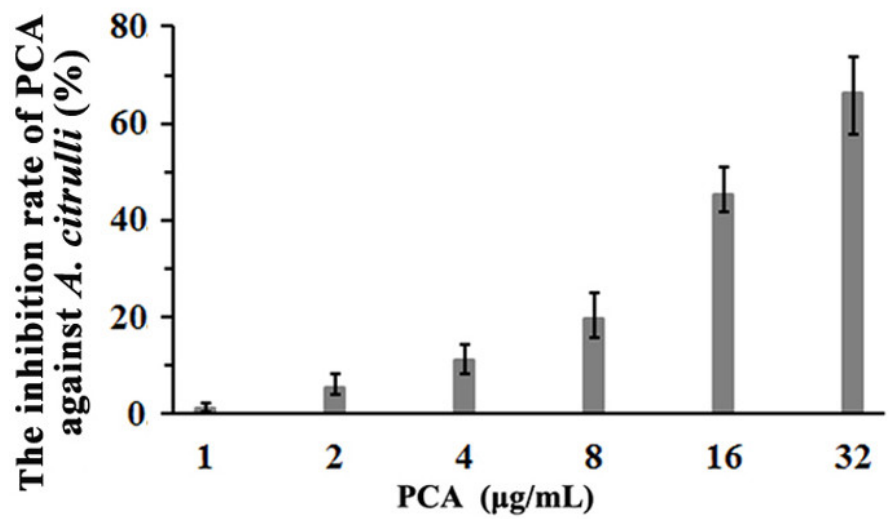
Figure 5. Inhibition effect of PCA at different concentrations on A. citrulli when cultured in liquid LB medium (200 rpm; 28 °C for 12 h). The experiment was repeated three times.